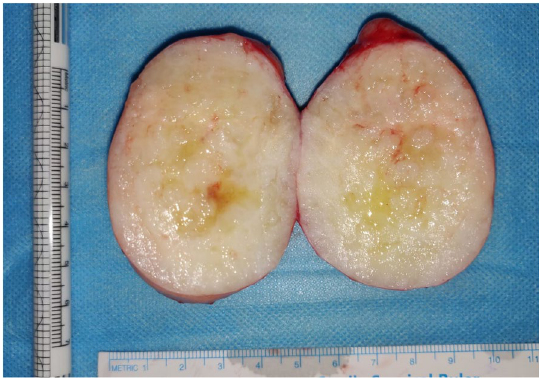
Fig. 6 Gross morphology of the excised tumor. A well-encapsulated globular tissue measuring 6 white stroma on the cut